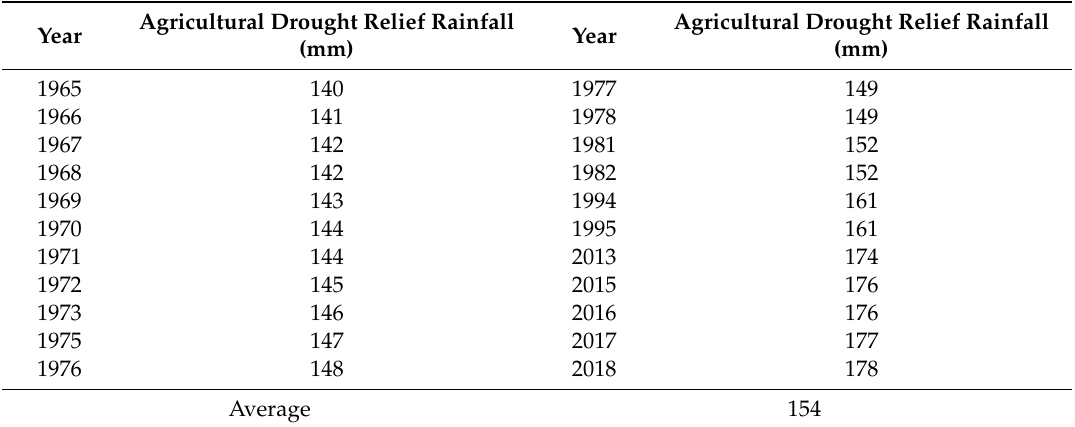
Table 6. Analysis of disaster-reduction rainfall by year considering linear regression